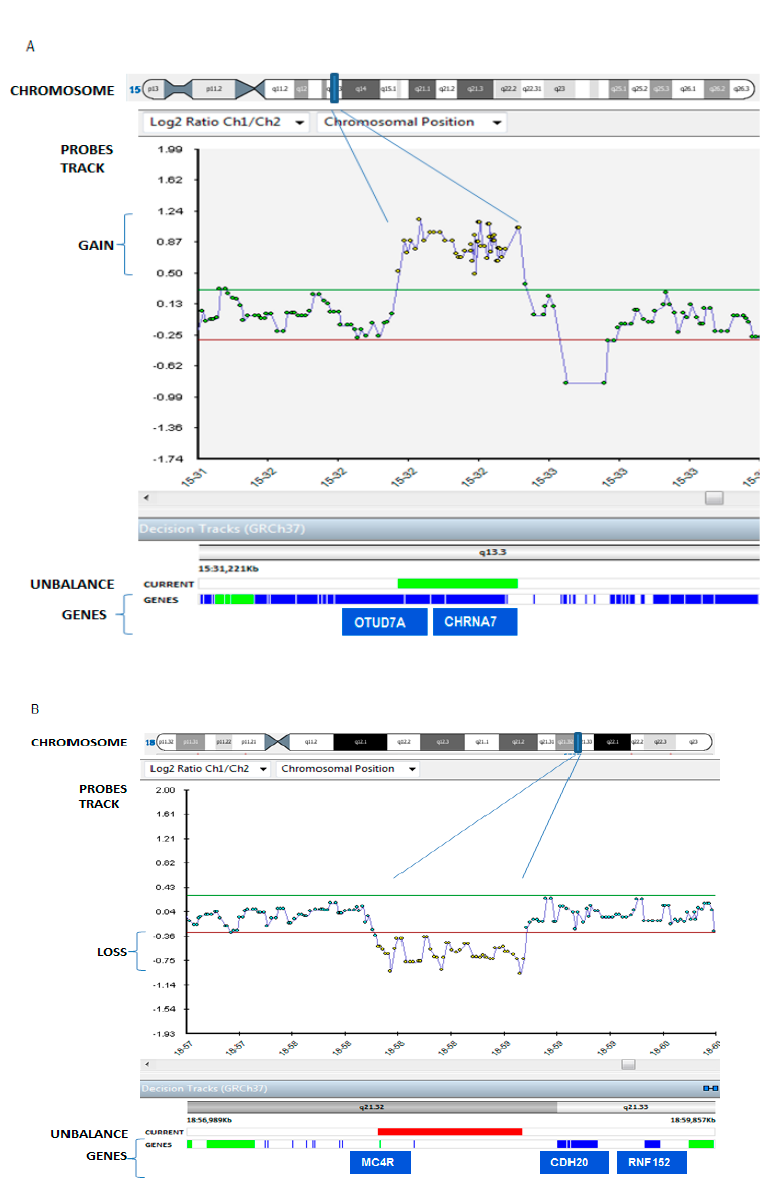
Figure 2. Patient’s array comparative genomic hybridization (aCGH) data result. The patient carried: (panel A) a 484 Kb microduplication in the chromosomal region 15q13.3 (the blue bar in the chromosome track), from 32065077 to 32539670 chromosome coordinate, zoomed in the probes track as indicated by purple lines, and (panel B) a 786 Kb microdeletion in the 18q21.32 region (the blue bar in the chromosome), from 58014483 to 58816361 chromosome coordinate, zoomed in the probes track as indicated by purple lines. Duplication and deletion are revealed by a disclosure of at least 3 probes from the +0.4 (duplication)/ − 0.6 (deletion range) of Log 2 ratio value in X axis (normal values are included in the range from +0.30, green line, to − 0.30, red line; probed duplicated and deleted in the patient are yellow in the figure, while green dots are balanced probes. In the track “unbalance”, the patient’s duplication in panel A and the patient’s deletion in panel B are indicated with a green and red bars respectively. Genes are represented as blue strips in the genes truck, and genes associated with pathology are colored in green.